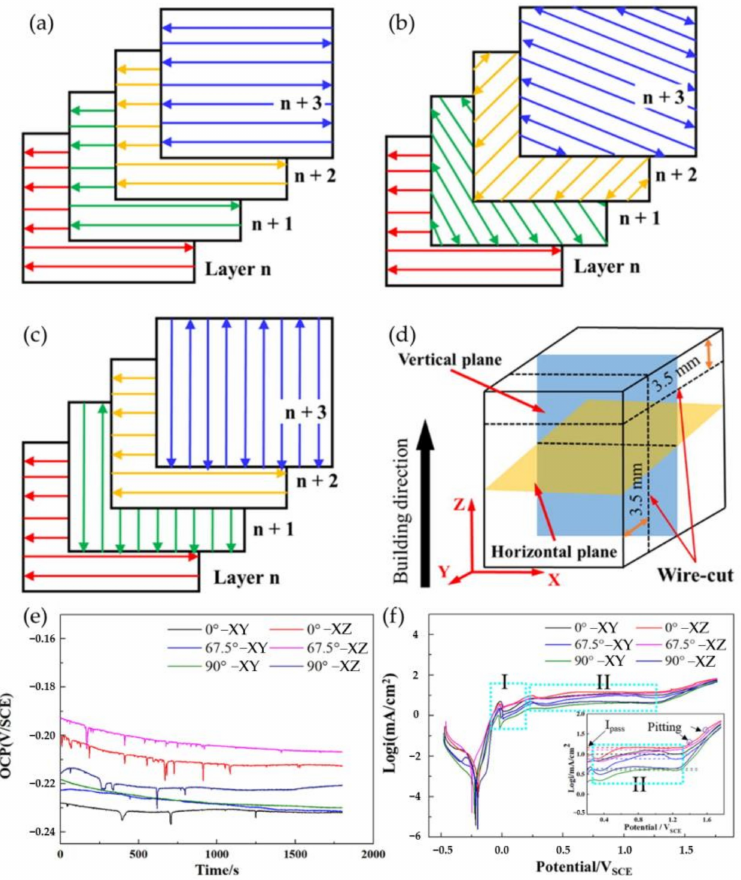
Figure 12. The scanning strategies used by Zhao et al. [108] consist of an ( a ) ◦ 0, ( b ) 67.5 ◦ , and ( c ) 90 ◦ rotation along the ( d ) XY and XZ planes. The ( e ) OCP and ( f ) potentiodynamic polarization scans of the samples in NaCl 3.5 wt.%